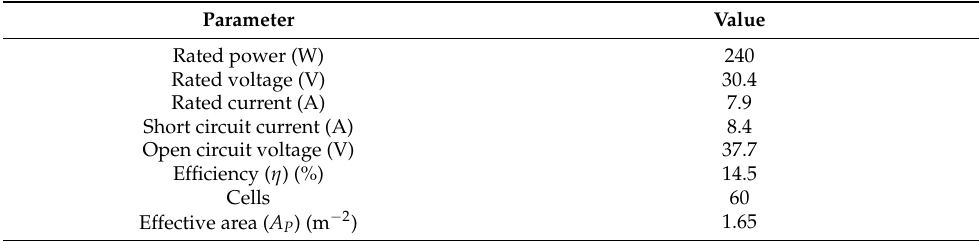
Table 1. Electrical generation properties for the REC Solar REC240PE-BLK modules at standard test conditions.